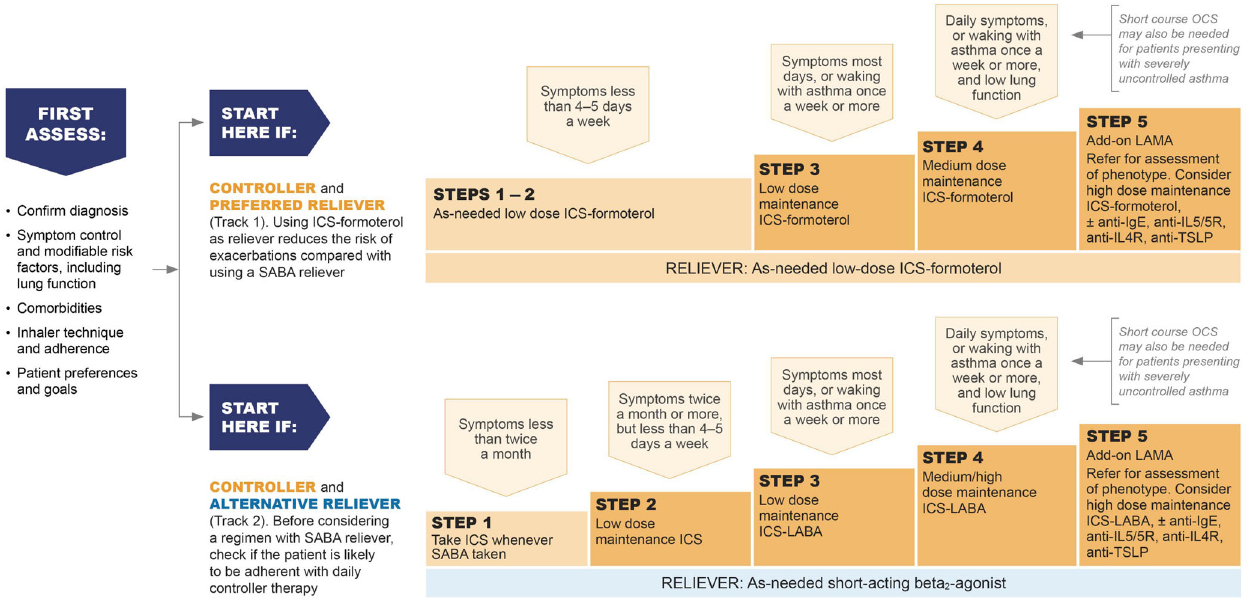
Fig. 5 Initial medications for adults and adolescents diagnosed with asthma. ICS inhaled corticosteroid, LABA long-acting beta 2 agonist, LAMA long-acting muscarinic antagonist, MART maintenance and reliever therapy with ICS – formoterol, OCS oral corticosteroids, SABA short- acting beta 2 agonist. Initial medications for adults and adolescents diagnosed with asthma, with guidance on initial levels of medication for each treatment track based on symptoms and lung function where appropriate. Refer to the GINA report for other treatment components, including treatment of modi fi able risk factors and comorbidities, non-pharmacologic strategies, and education and skills training. Source: Box 3.4Bi in GINA report 2022. Reproduced with permission from ref. 11